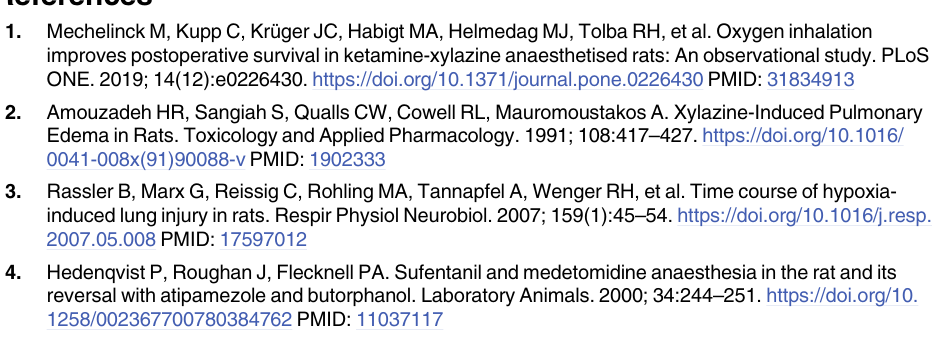
S1 Table. Vital signs of rats under fentanyl/fluanisone and midazolam anaesthesia with and without oxygen during a post-operative period of one hour. S2 Table. Blood acid-base status of rats under fentanyl/fluanisone and midazolam anaes- thesia with and without oxygen during a post-operative period of one